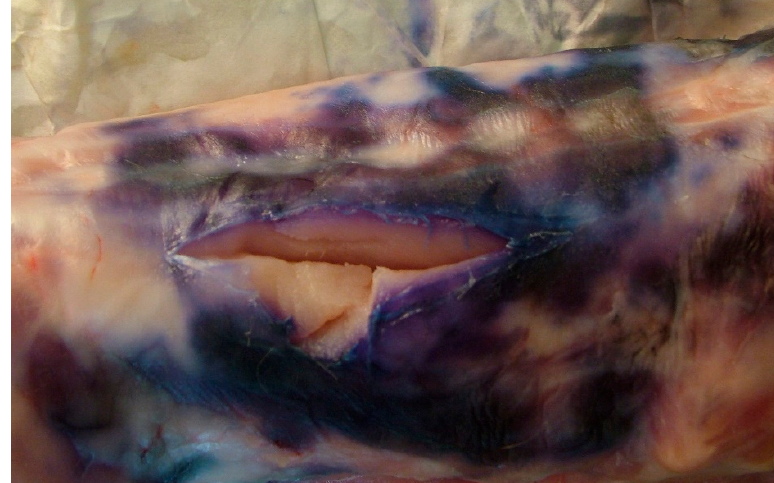
Figure 1. Chromatic alteration observed on the surface of the carcasses.